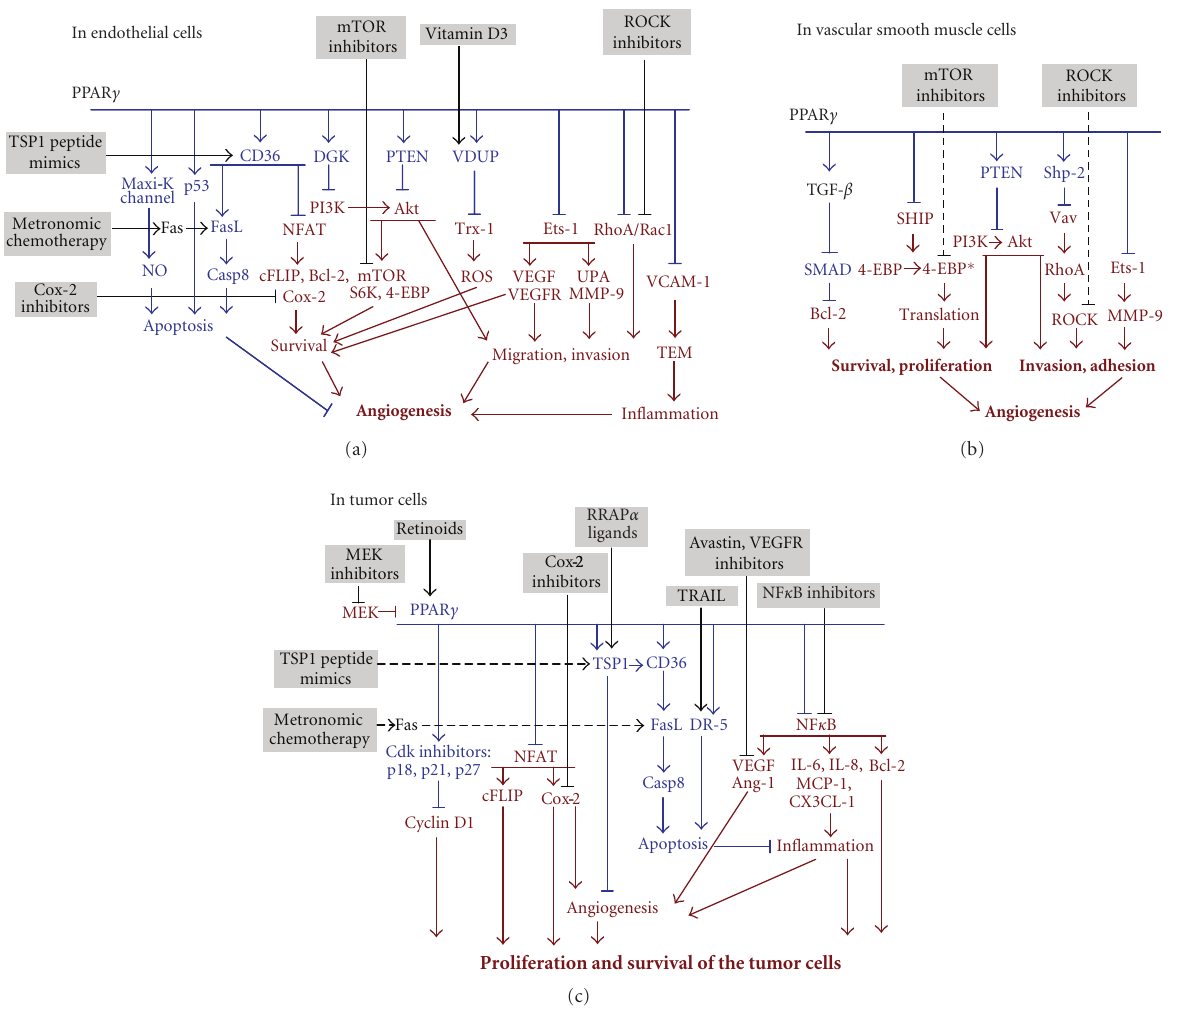
Figure 4: PPAR γ e ff ects on the endothelial, pericytic, tumor and immune cells in the tumor microenvironment: the consequences of angiogenesis and possible ways to augment antitumor actions. Pro-angiogenic and tumor-promoting events are shown in red. The opposing e ff ects are in blue. The proposed drugs are shown in black. (a) Summary of the PPAR γ molecular e ff ects in the endothelial cells. TEM, transendothelial migration. (b) PPAR γ molecular e ff ects on the VSMCs. (c) The e ff ects on macrophages and tumor